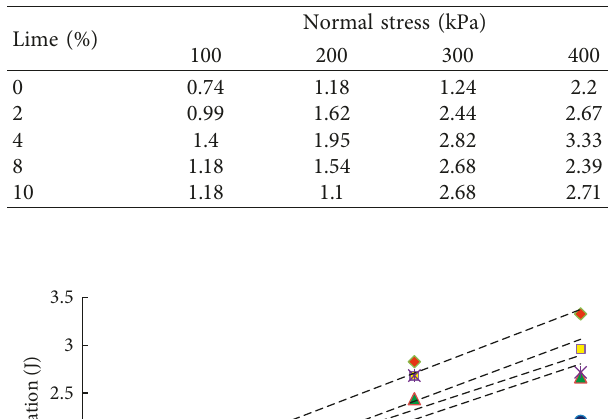
Table 4: Shear energy dissipation of iron tailing powder with different lime doses under different normal stresses ( J ).